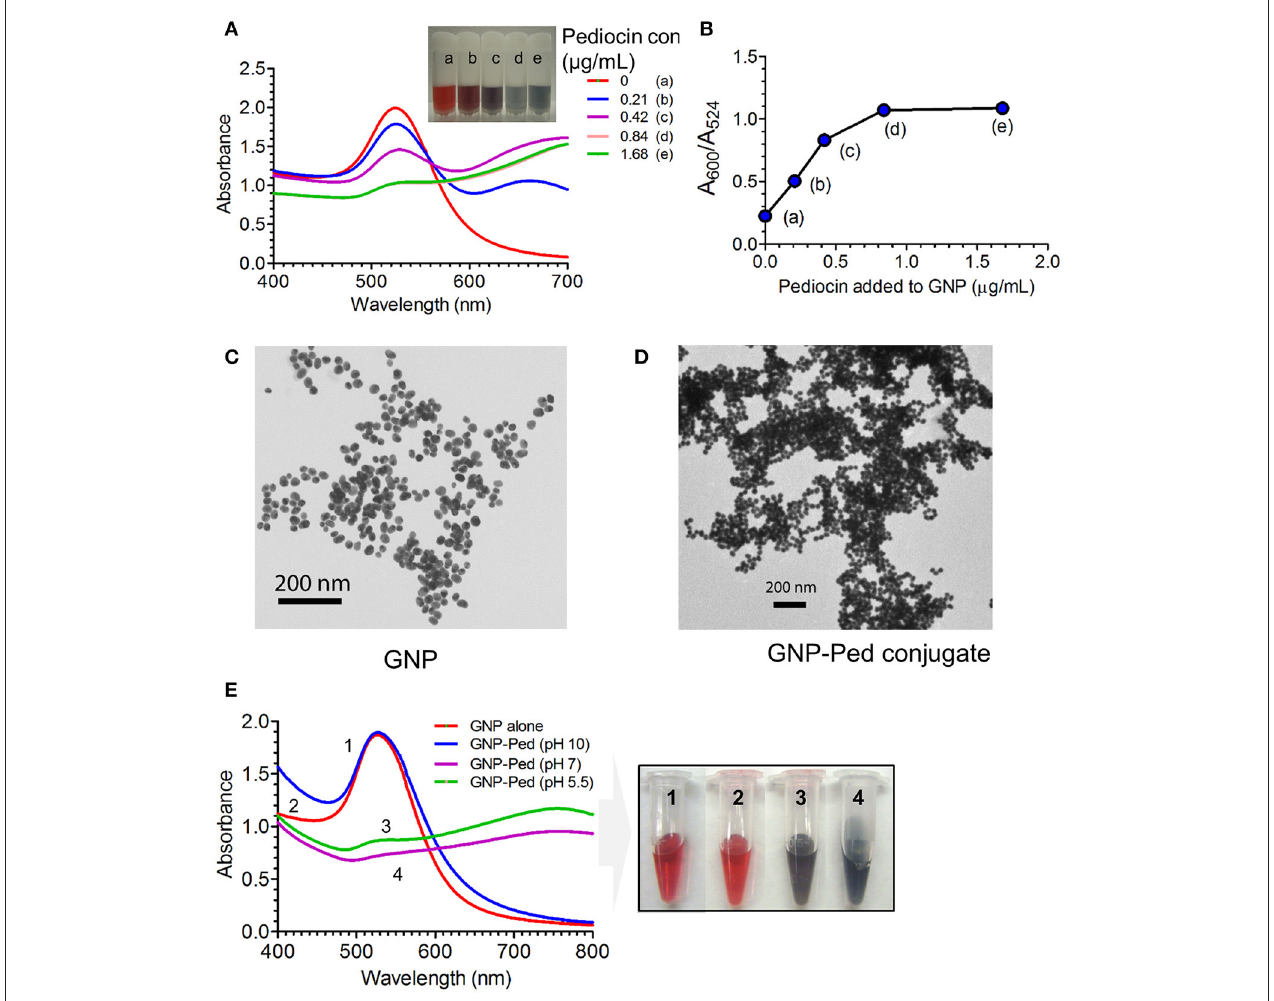
FIGURE 1 | Interaction of Pediocin AcH with gold nanoparticle (GNP). (A) Effect on the surface plasmon resonance (SPR) absorbance peak and color of GNP after interaction with different concentrations of Pediocin AcH. (B) The ratio of absorbance at 600nm and 524nm for GNP-Pediocin nanocomposite increased with the increasing concentrations of Pediocin AcH suggesting increased loading onto the gold nanoparticles. (C) TEM measurement of GNP revealed particle size to be ∼ 20nm. (D) TEM measurement of GNP after interaction with 1.68 µ g/ml of Pediocin AcH demonstrating GNP-Pediocin conjugate size to be about 40nm. (E) Quantitative and qualitative measurements demonstrating the effect of pH on the electrostatic interaction between the citrate-stabilized GNP and Pediocin.